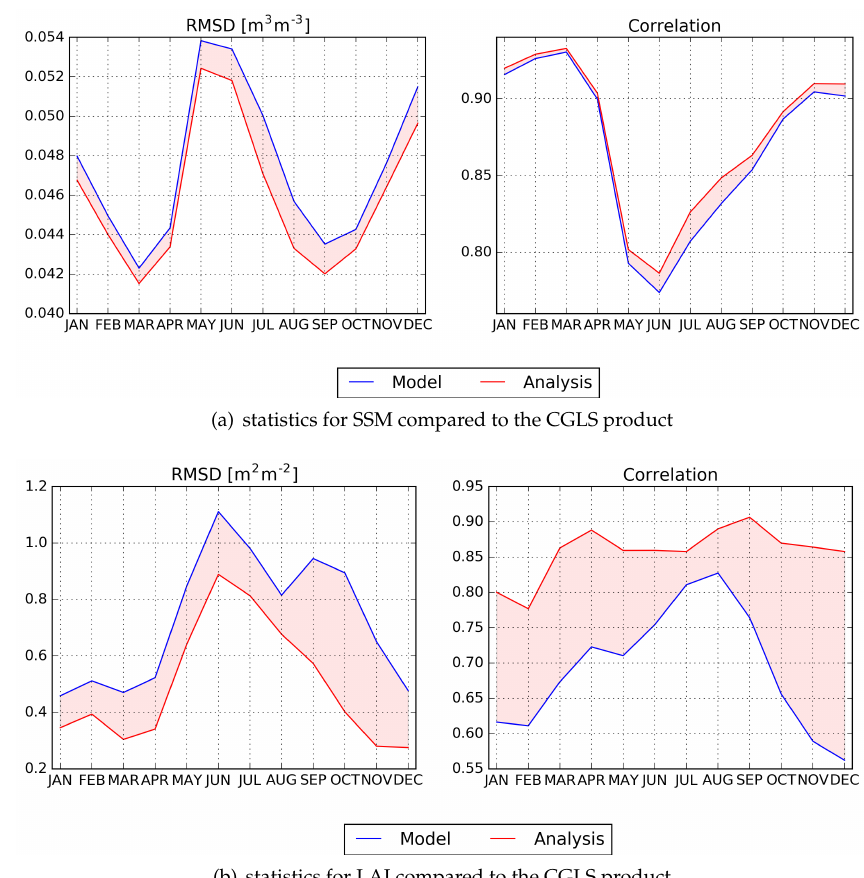
Figure 3. Monthly seasonal scores (RMSD and correlation R) of the open-loop (blue) and analysis (red) simulations from 2007–2015 averaged over the Euro-Mediterranean area compared to the observations of: ( a ) SSM and ( b ) LAI. Red shade indicates an improvement from the assimilation process with either a lower error or a higher correlation